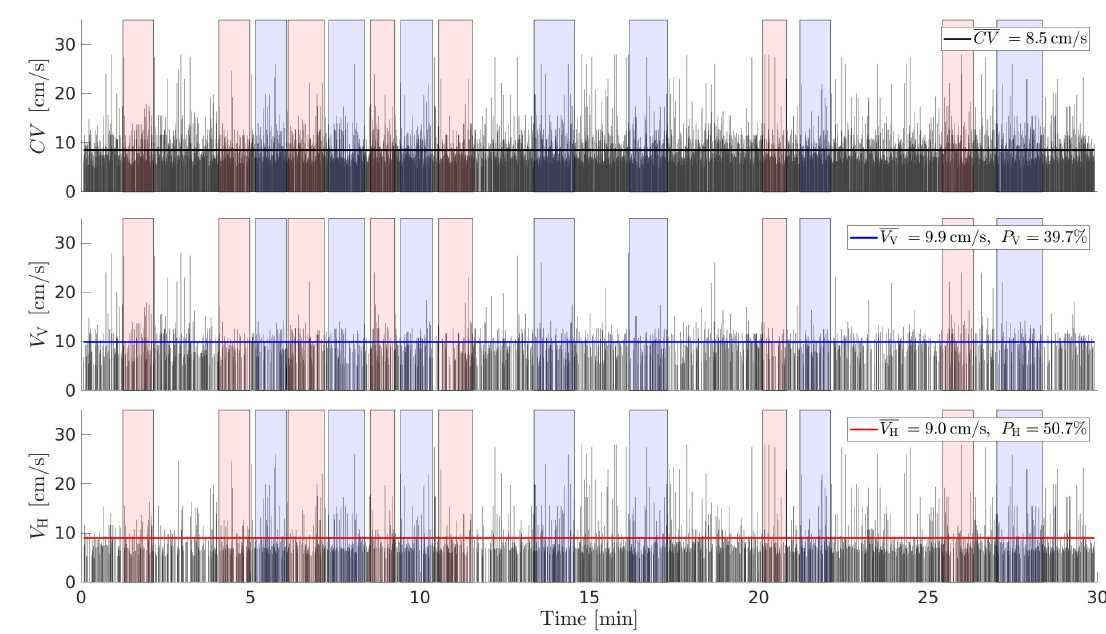
Figure A3. Conduction velocity amplitudes, CV , and conduction velocity amplitudes in the vertical, V V , and horizontal, V H , directions of the record tpehgt_p006 in the frequency band B1. CV —the average conduction velocity. V V , V H —the average conduction velocities ( CV (cid:54) = 0) in the vertical and horizontal directions. P V , P H —the percentages of conduction velocities in the vertical and horizontal directions. Blue: dummy intervals, red: contraction intervals.